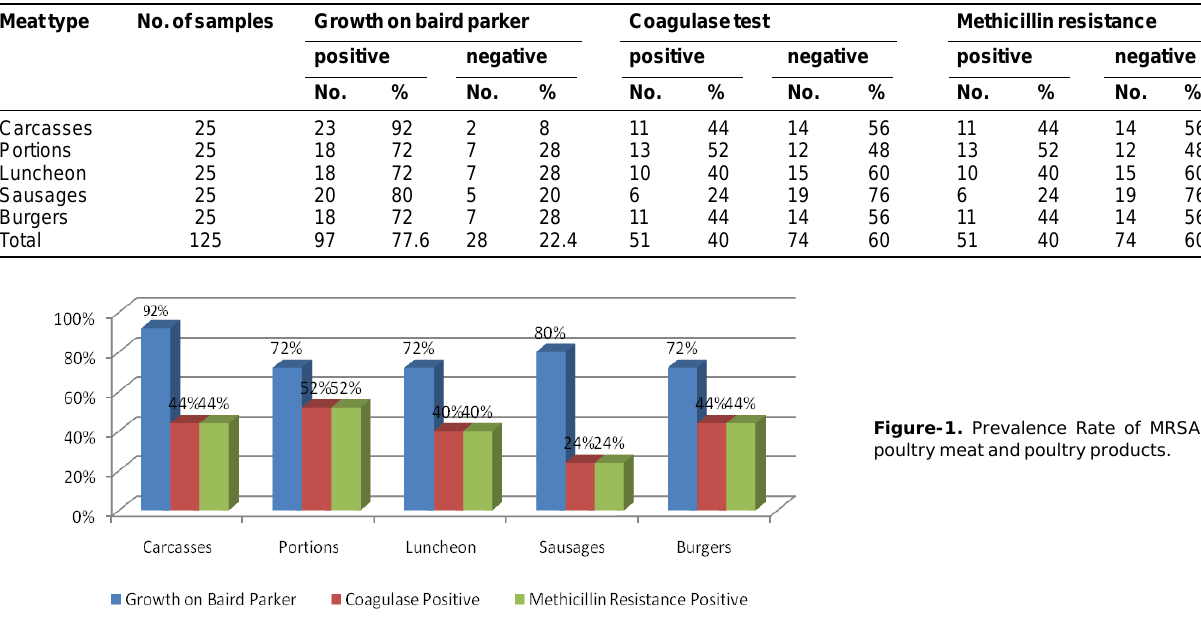
Table-1. Prevalence of MRSA in poultry meat and poultry products. Meat type